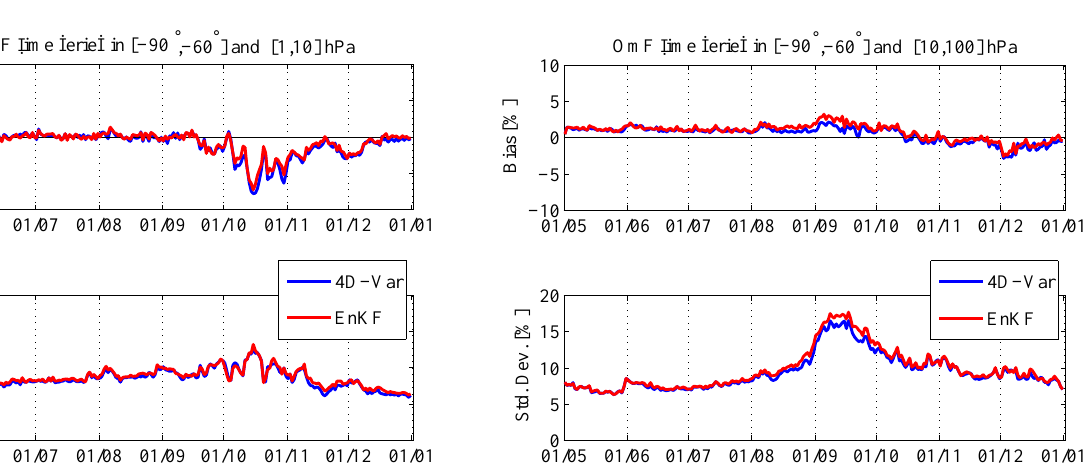
Figure 4. Observation-minus-forecast statistics for the EnKF (red lines) and the 4D-Var (blue lines) with respect to the assimilated EOS (earth observing system) Aura-MLS data for the period of September and October 2008. Bias (top row) and standard deviation (bottom row) for five different latitudinal bands. The green or red stars show the result of the Student’s and Fisher’s tests of significance on the 95% level (see text).